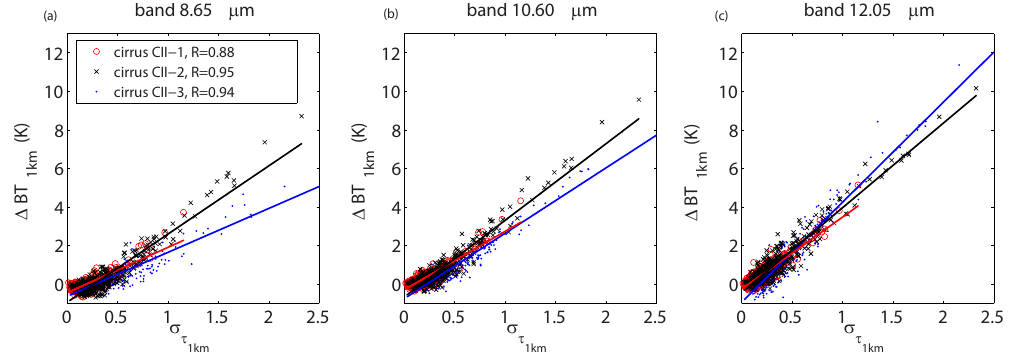
Figure 15. Brightness temperature differences, 1 BT 1km , viewed at the nadir as a function of the optical thickness standard deviation σ τ for cirri CII-1, CII-2 and CII-3 and for the bands at 8 . 65µm, 10 . 60µm and 12 . 05µm.